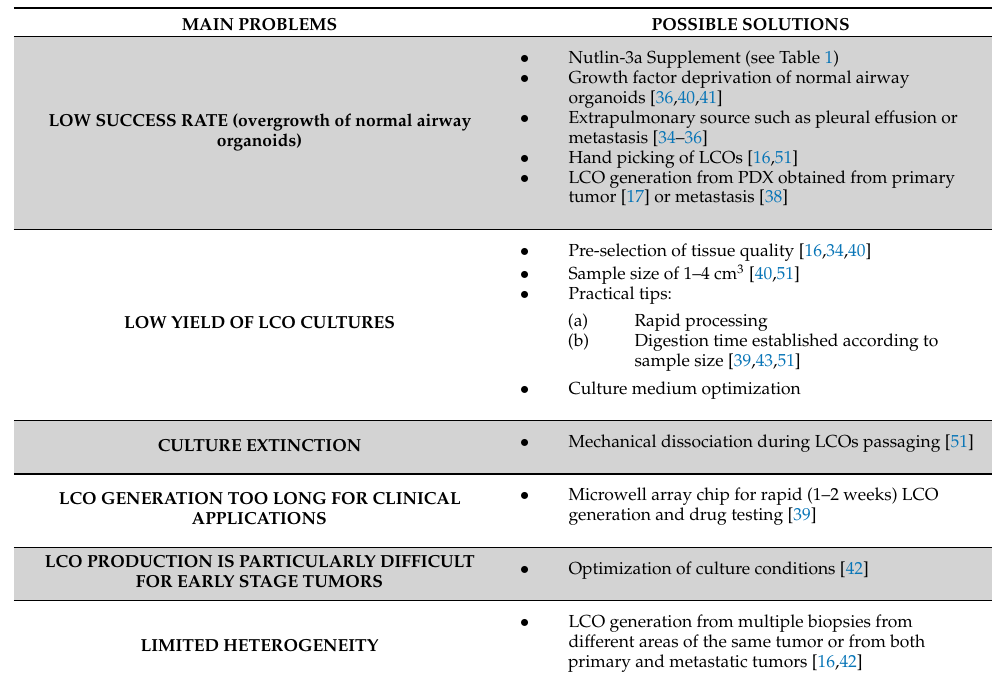
Figure 1. Timetable of landmark studies that have contributed to the generation of 3D cultures of lung epithelial cells. LCOs, lung cancer organoids; SCLC, small ‐ cell lung cancer; NSCLC, non ‐ small ‐ cell lung cancer; PDX, patient ‐ derived xenograft [9,16,17,22–25,27,32,34,35,37–40,42,44,58–60]. Table 2. Major problems encountered in the generation and culture of lung cancer organoids and possible solutions. LCOs, lung cancer organoids; PDX, patient ‐ derived xenograft.